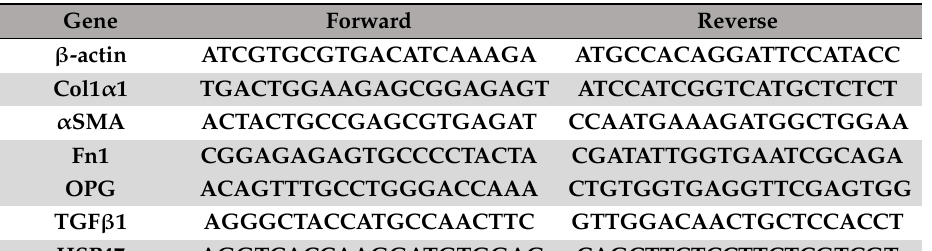
Table A1. Sequences of the primers used in this study.